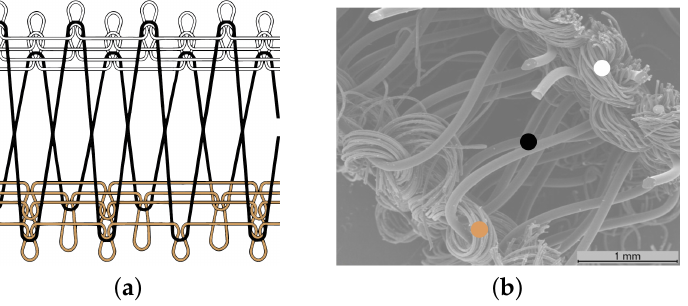
Figure 4. Scheme of the SIGP: ( a ) Weft-knitting structure diagram based on [18], where the white, black and brown yarns correspond to the dielectric, spacer and conductive yarns, respectively; ( b ) SEM image of SIGP, with 35X